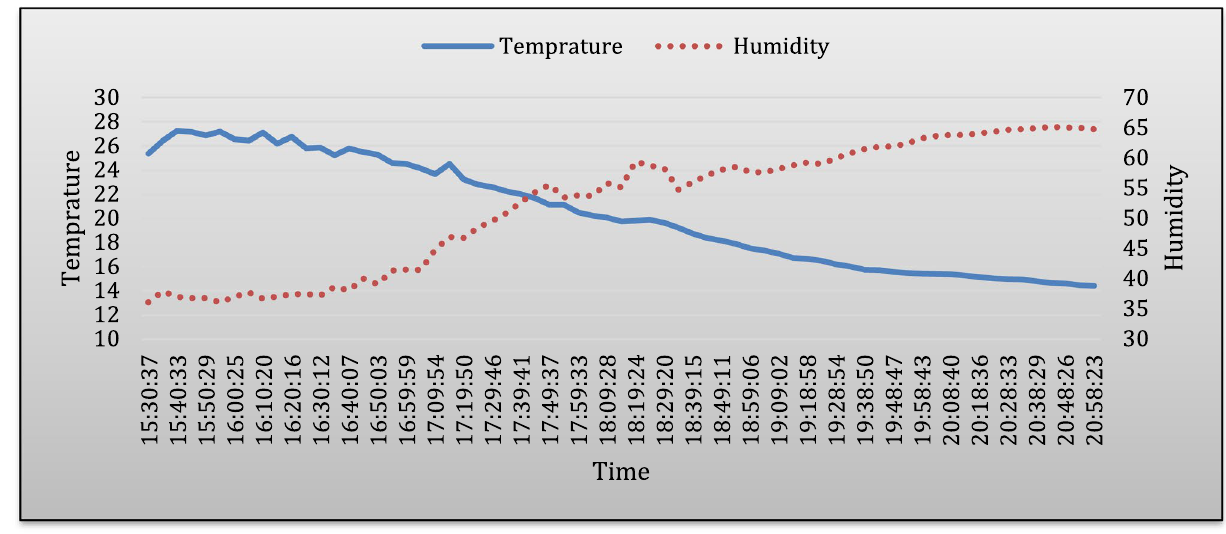
Fig. 8 Results of the experiment carried out on 10.31.2019